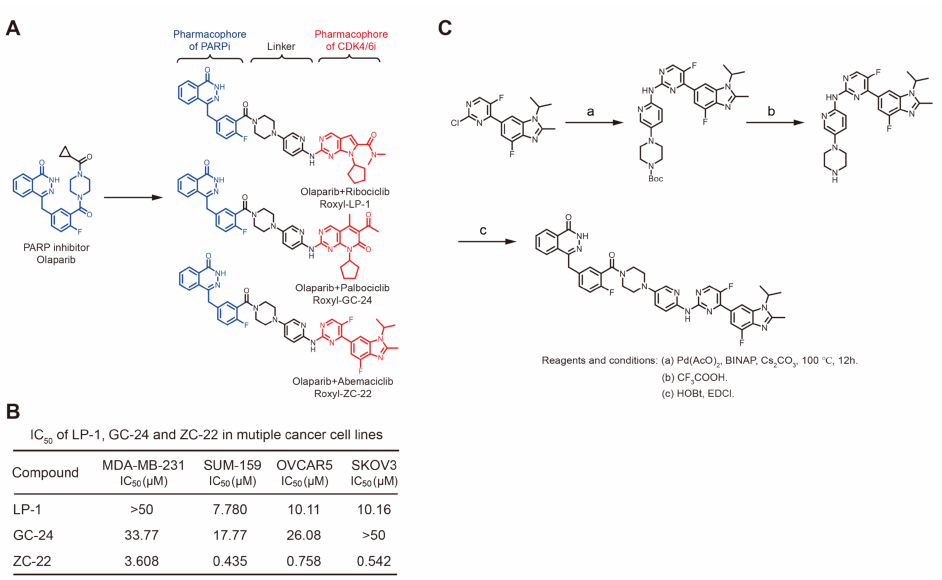
Figure 1. Synthesis strategy and activity assay of the novel compounds targeting both PARP and CDK4/6. ( A ) Synthesis strategy of the three novel compounds GC-24, LP-1, and ZC-22. ( B ) IC 50 of GC-24, LP-1, and ZC-22 in breast and ovarian cancer cells. Cells were treated with increasing concentrations of GC-24, LP 1, or ZC-22 for 6 days with replenishment of medium every 2 days. Cell proliferation was analyzed by CCK-8 assays. ( C ) The reagents and conditions used for the chemical synthesis of ZC-22 in this study: (a) Pd(AcO) 2 , BINAP, CS 2 CO 3 , 1,4-Dioxane, 100 ◦ C, 12 h; (b) CF 3 COOH, DCM, Room temperature, 6 h; (c) HOBt, EDCI, DIPEA, DMF, Room temperature, 12